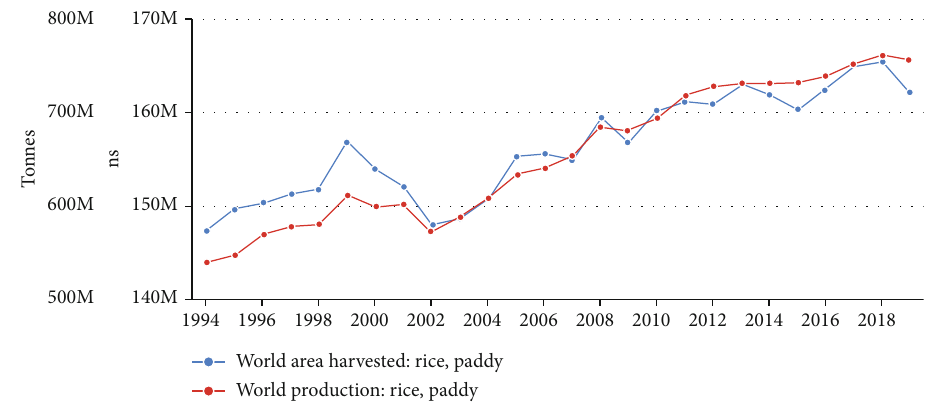
Figure 1: World production of rice in 1994-2019